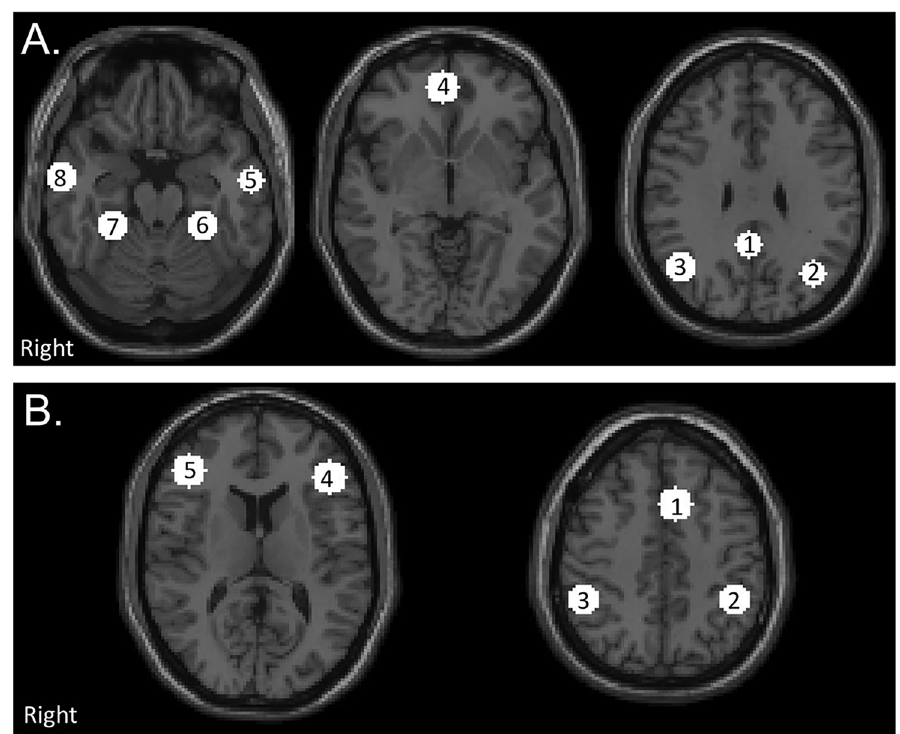
Fig 1. Location of network regions of interests (ROIs). (A) Default Mode Network (DMN). 1) PCC Posterior cingulate cortex (PCC) 2) Left Lateral Parietal (LLP) 3) Right Lateral Parietal (RLP) 4) Medial Prefrontal Cortex (MPFC) 5) Left Inferior Temporal Gyrus (L ITG) 6) Right Inferior Temporal Gyrus (R ITG) 7) Left Medial Temporal Lobe (L MTL) 8) Right Medial Temporal Lobe (R MTL). (B) Task Positive Network (TPN). 1) Premotor Area (PM) 2) Left Supramarginal Gyrus (L SMG) 3) Right Supramarginal Gyrus (R SMG) 4) Left Dorsolateral Prefrontal Cortex (L DLPFC) 5) Right Dosolateral Prefrontal Cortex (R DLPFC). Networks consists of 10 mm spherical ROIs centered around the peak correlated voxel with the PCC for the DMN and the bilateral DLPFC for the TPN from the results of an independent control group thresholded at a voxel wise p -value of 0.001 (uncorrected) and cluster extent threshold of p -value of 0.001 (FWE).